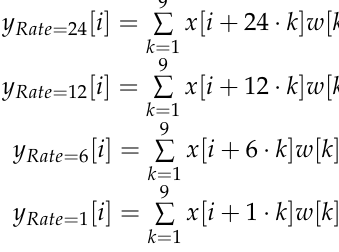
Figure 12. ML-ASPP in the encoder.